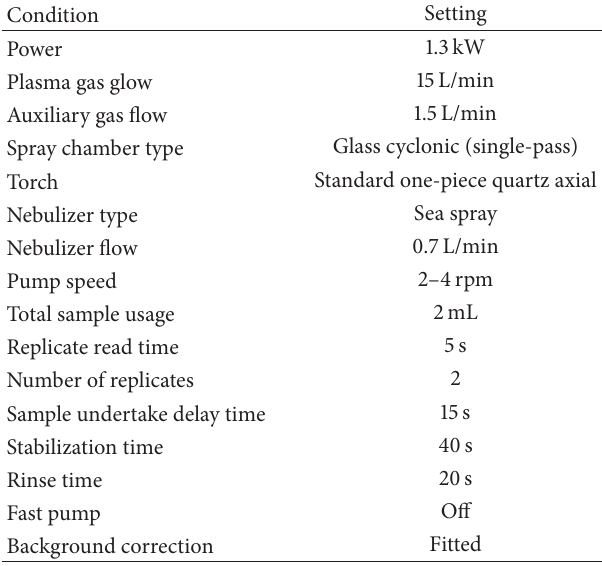
Table 1: The operating conditions of the